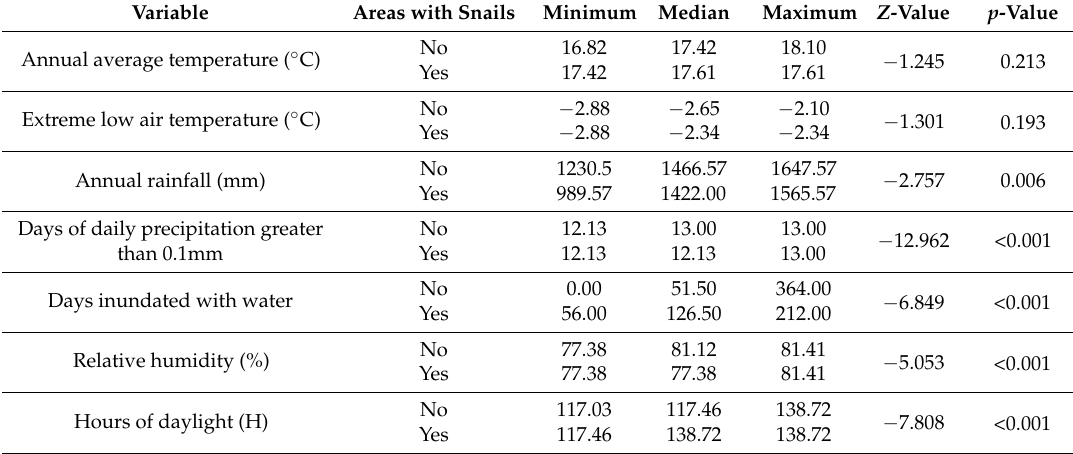
Table 1. Minimum, median and maximum of the air temperature, precipitation, days inundated with water, relative humidity and hours of daylight in different areas. Variable Areas with Snails Minimum